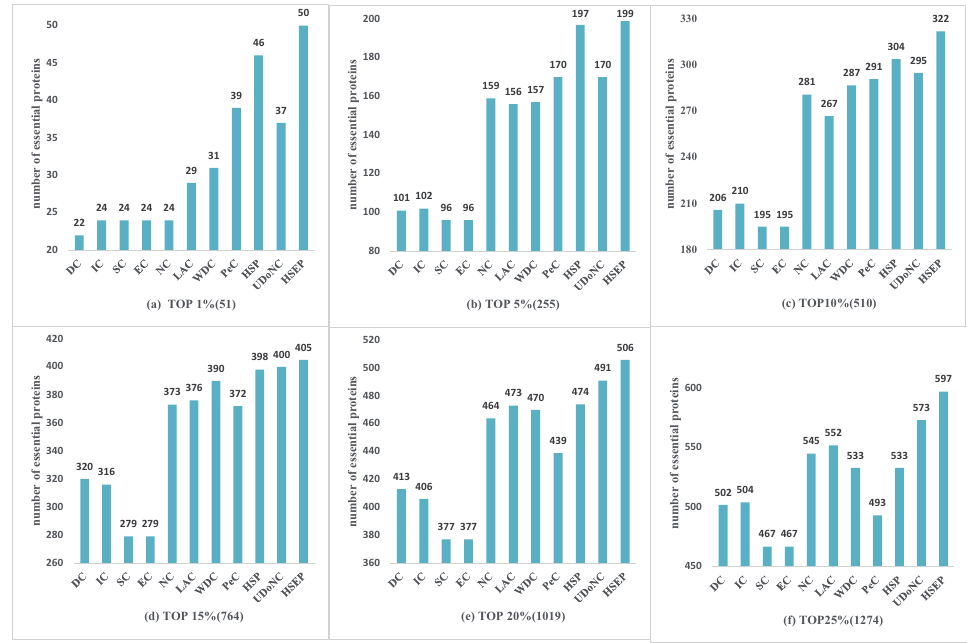
Figure 3. Comparison of HSEP with other essential protein discovery methods: ( a ) Top 1% (Top 51);